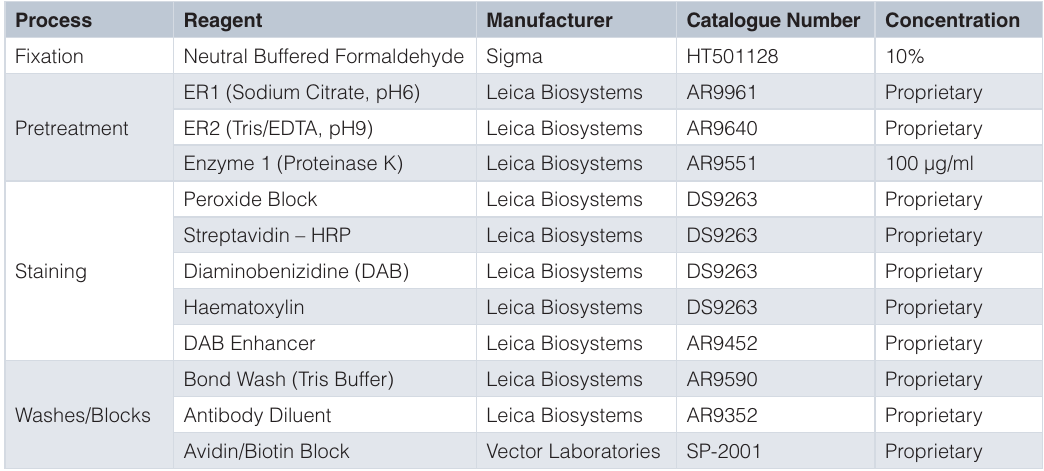
Table 1. Details of ancillary reagents for